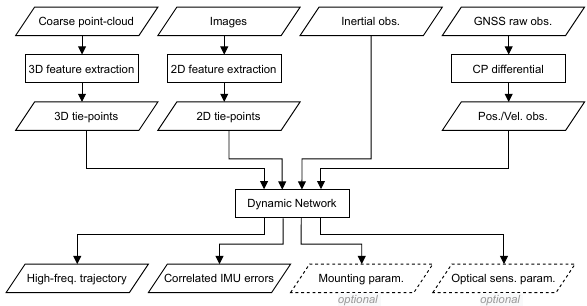
Figure 2. Integration of all the available sensor information in a single step. The 3D tie-point extraction is performed on a point- cloud that has previously been geo-referenced by means of an INS/GNSS trajectory obtained via recursive smoothing.